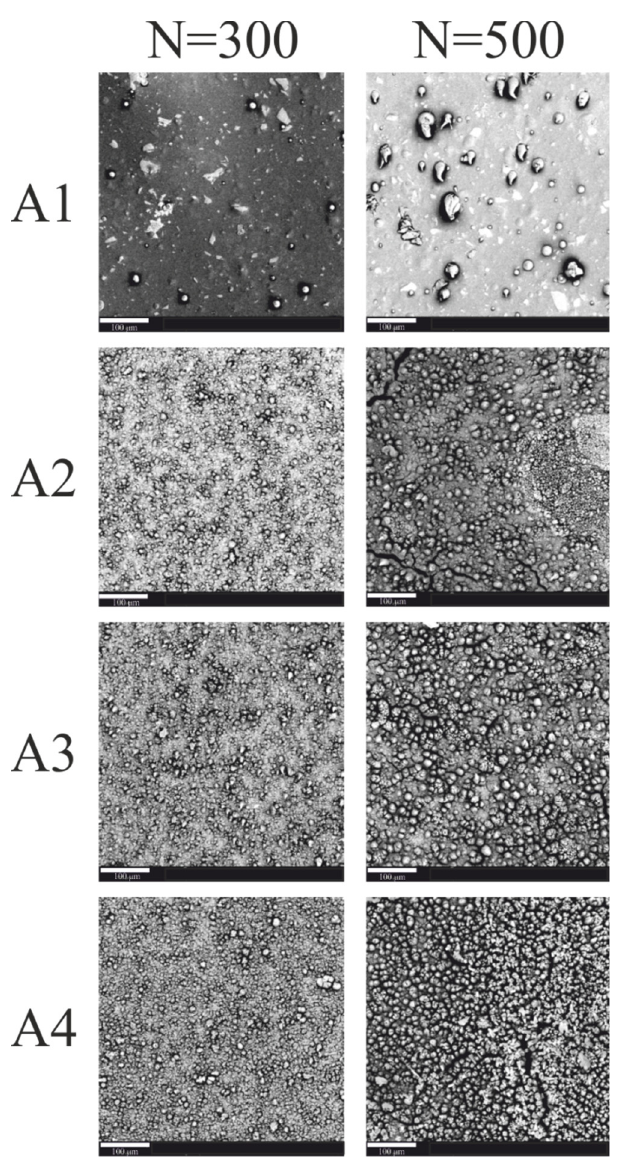
Figure 3. SEM images of A1–A4 coatings (scale—100 μ m).